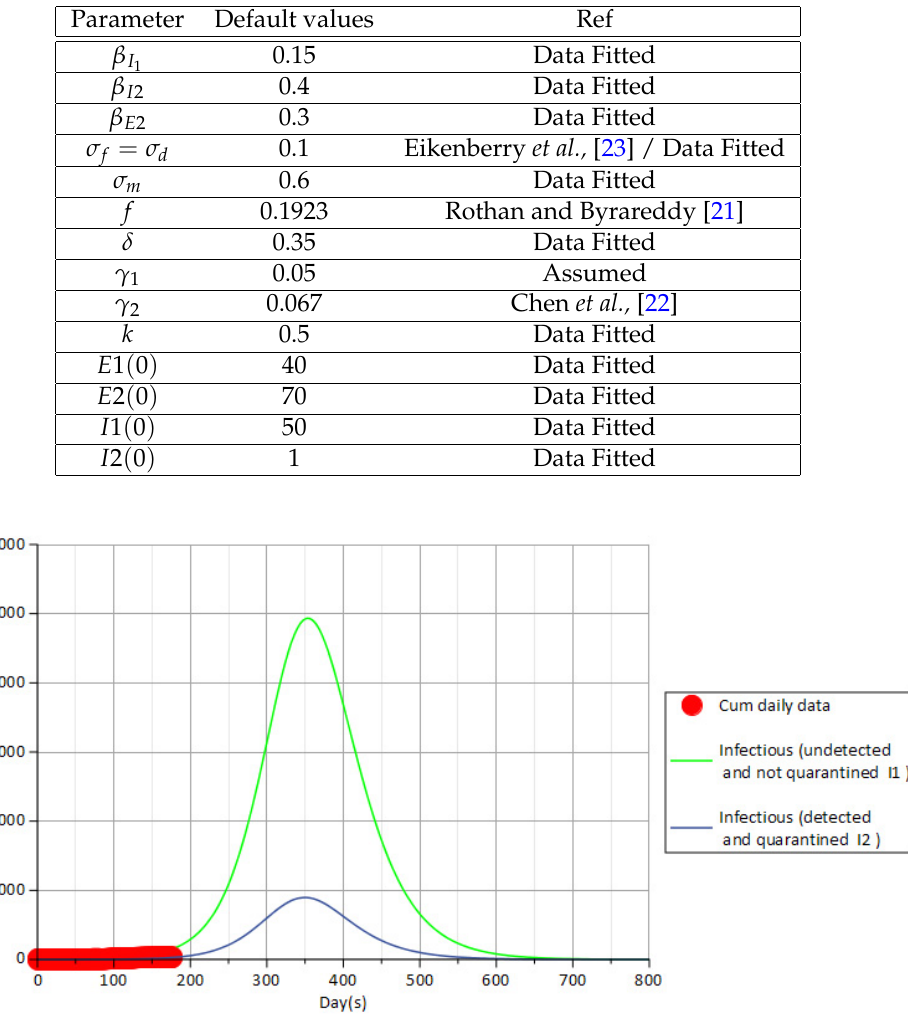
Figure 3. Cumulative daily infectious individuals (red), I 1 ( t ) (green) and I 2 ( t ) (blue) for face masks usage σ f = 0.01 with other parameters as in Table